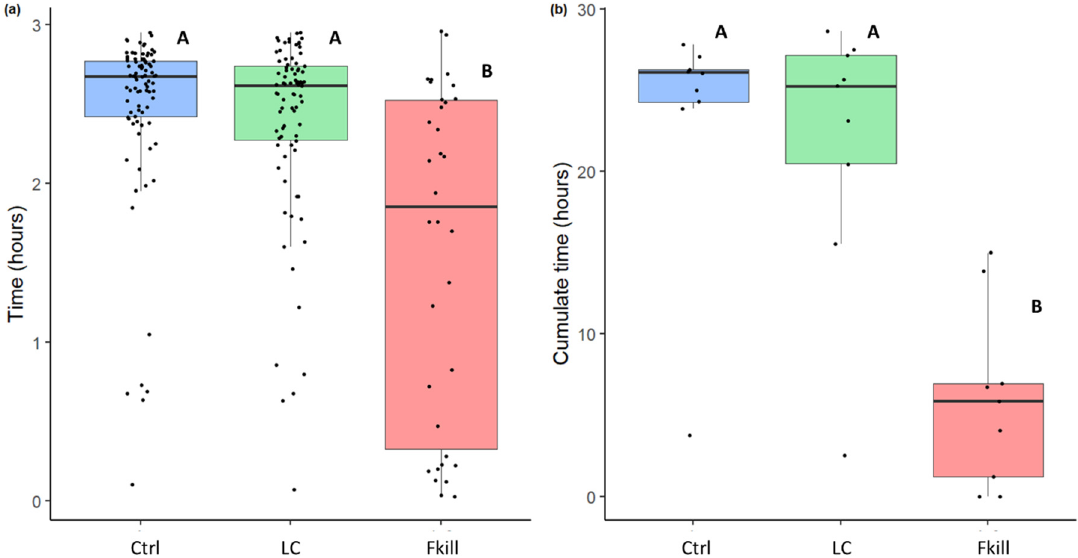
Figure 2. ( a ) Length of time that dead flies remained inside the nest depending on their level of infection. Blue: control flies (n = 85), green: flies covered with conidia (n = 82), red: fungus-killed flies (n = 34). ( b ) Global exposure of ant colonies to prey items. This exposure level is the cumulated lengths of time that all flies remained inside the nest. Blue: control flies (n = 9), green: flies covered with conidia (n = 9), red: fungus-killed flies (n = 9). The horizontal bar within the boxes represents the median; the upper and lower boundaries of the boxes represent, respectively, the 75th and 25th percentiles, while the whiskers extend to the smallest and largest values within 1.5 box lengths. Groups sharing a common letter were not significantly different.